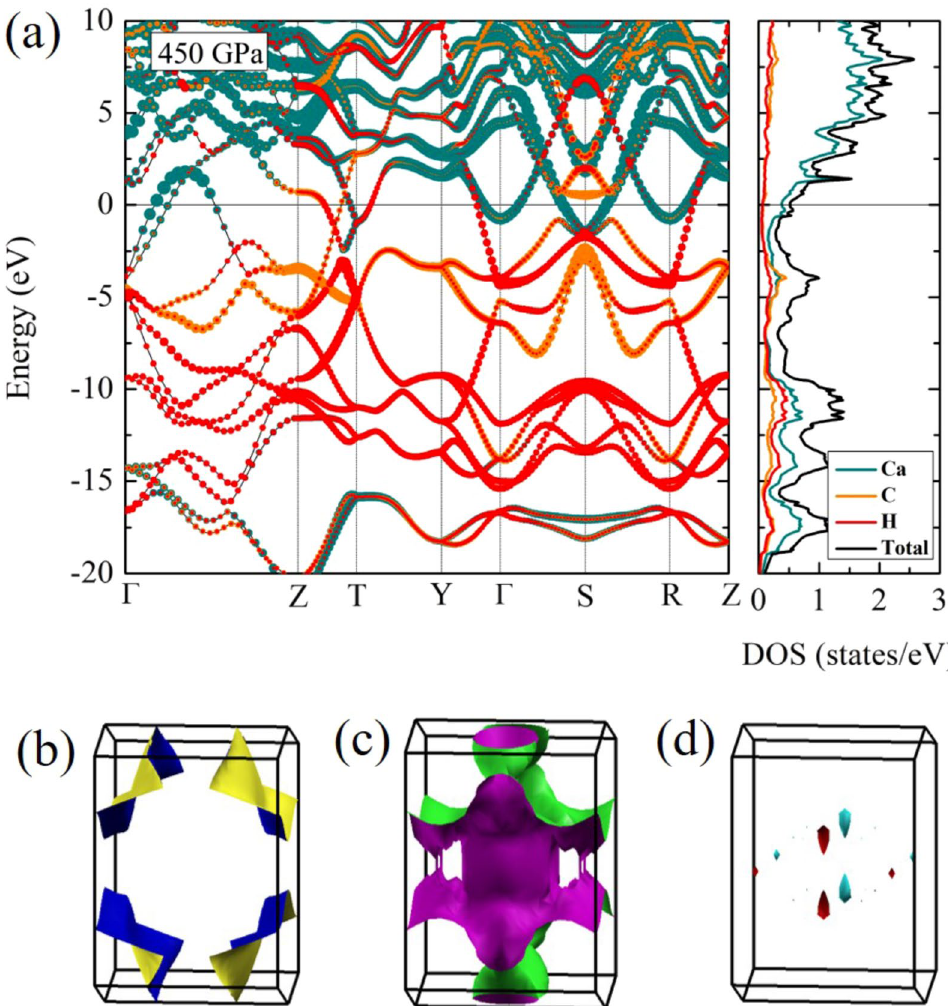
Figure 5. ( a ) The band structure of the Cmcm structure, where the dark cyan, orange, and red circles represent, respectively, Ca, C, H atoms, and density of states the Cmcm structure, where the dark cyan, orange, and red lines represent, respectively, Ca, C, H atoms, at 450 GPa. ( b – d ) the Fermi surface of the Cmcm structure at 450 GPa (drawn by XCrySDen program (ver. 1.5.60) 57 (URL http:// www. xcrys den. org/ Downl oad. html#_